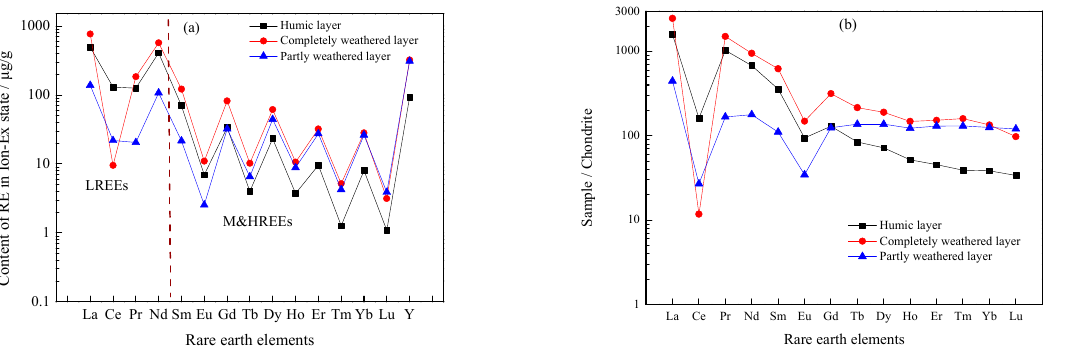
Figure 4. Rare earth contents and chondrite standard values of Ion exchange state. ( a ) Content of ion exchange state of rare earth elements in each weathered layer; ( b ) Standard for ion exchange state of rare earth element chondrites in each weathered layer.